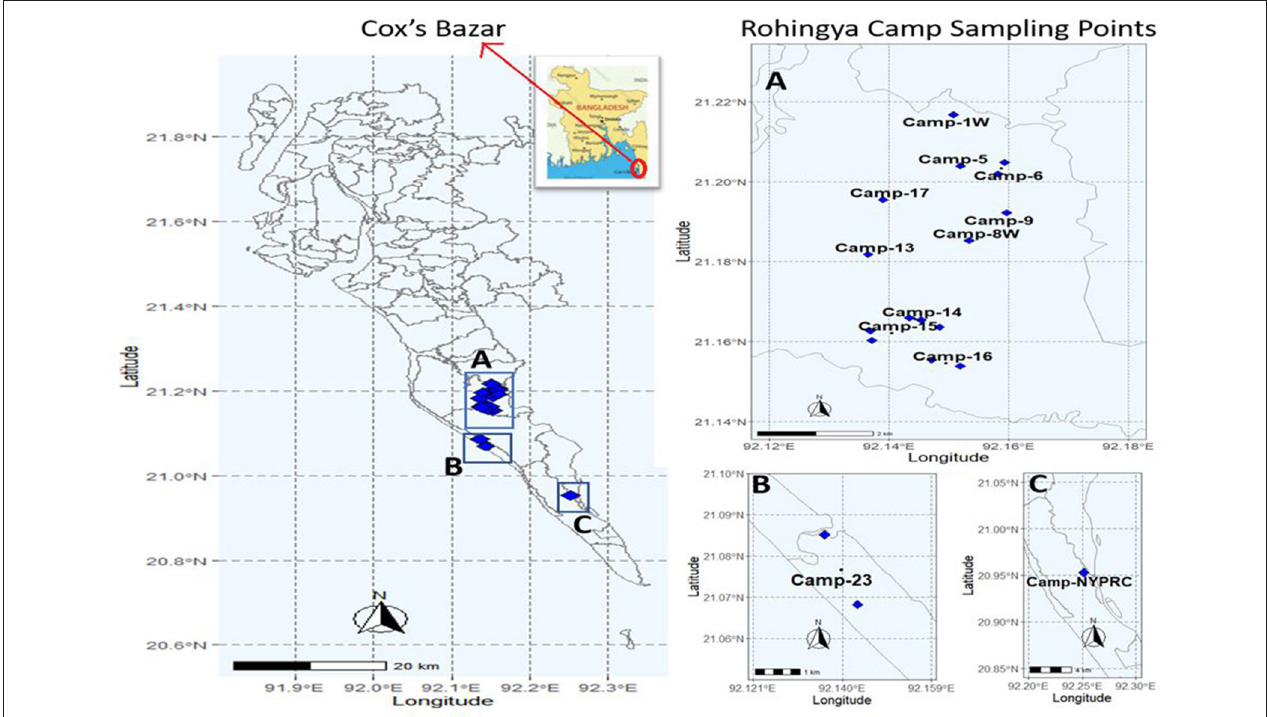
FIGURE 1 | Locations of sampling points in Rohingya camps, Cox’s